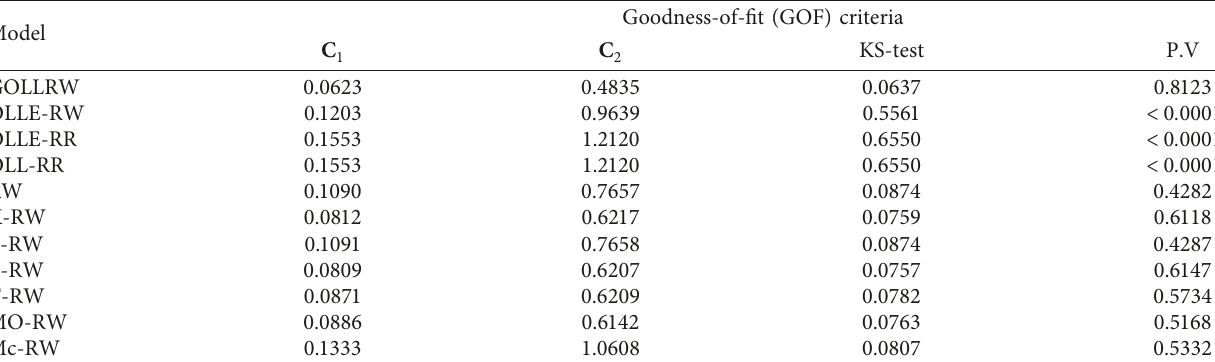
Table 8: C ₁ , C ₂ , KS-test, and P.V for stress data